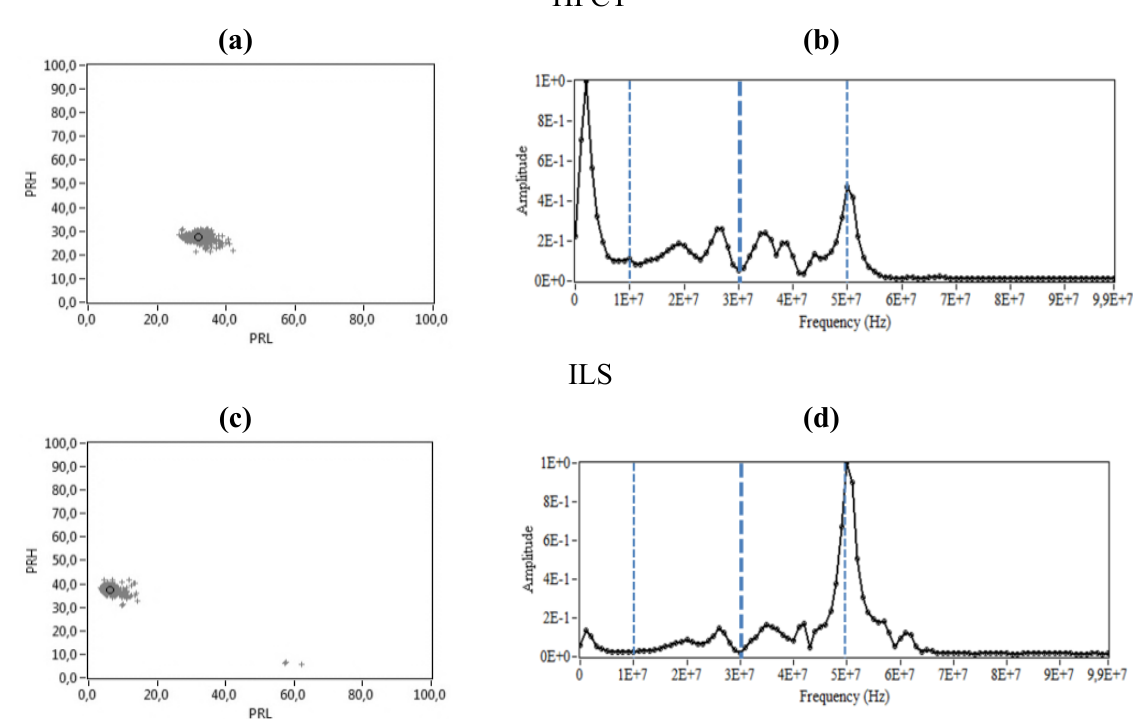
Figure 10. Corona PD. ( a ) PR map of the signals measured with the HFCT, ( b ) Normalized average spectral power of the signals measured with the HFCT, ( c ) PR map of the signals measured with the ILS, ( d ) Normalized average spectral power of the signals measured with the